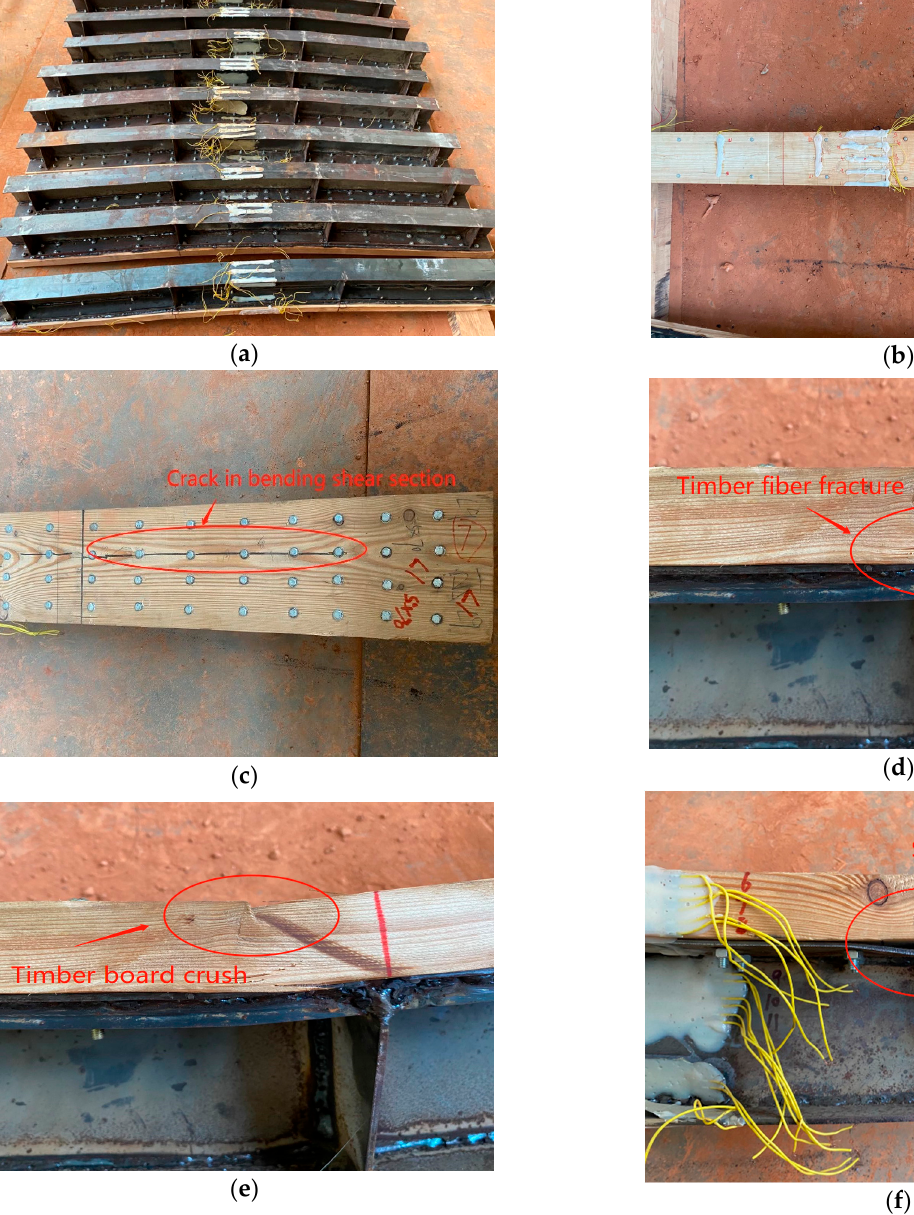
Figure 9. Phenomenon of test specimen: ( a ) the lower edge of I-beam is not broken (Note: All test specimens); ( b ) the timber is free of damage (Note: L1-1 test specimen and L4-2 test specimen); ( c ) longitudinal cracks of the bending-shearing section on the top surface of timber board (Note: L2-1, L2-4, L3-1, L3-2, and L4-1 test specimen); ( d ) longitudinal fracture of tensile zone of timber (Note: L2-1 test specimen); ( e ) the compression area of the timber is crushed (Note: L2-1, L2-2, and L3-1 test specimen); ( f ) buckling of upper flange of I-beam (Note: L3-1 test specimen).